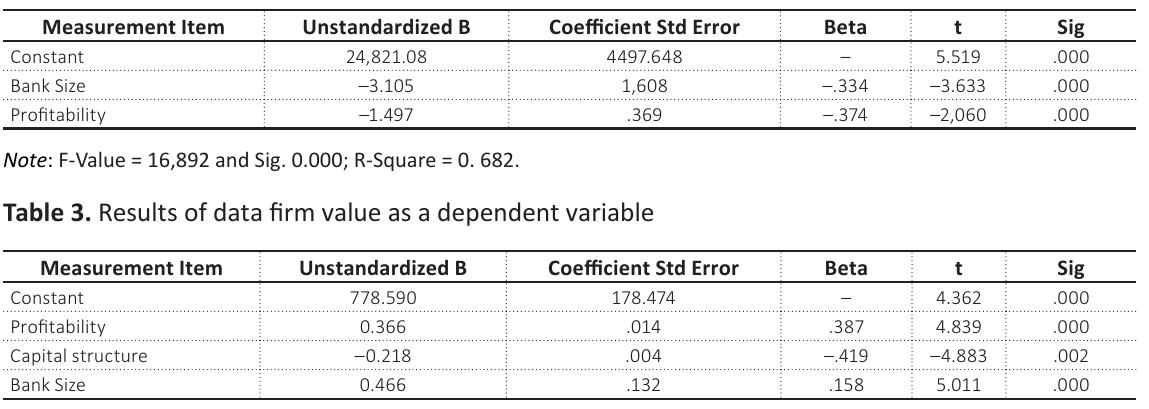
Table 2. Capital structure as a dependent variable